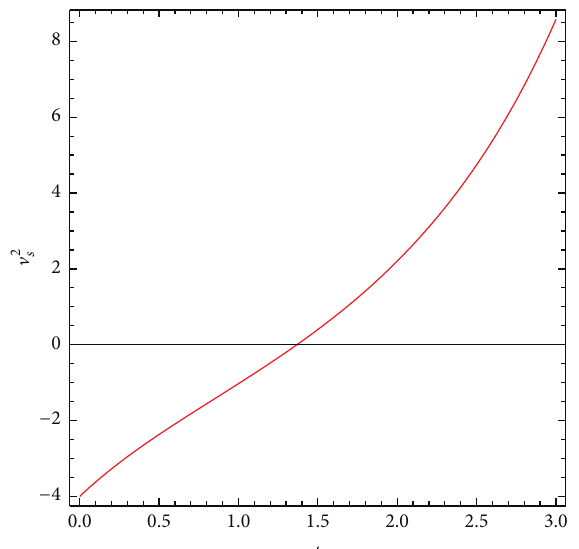
Figure 16: Plot of squared speed of sound with specific form of 𝐻 .